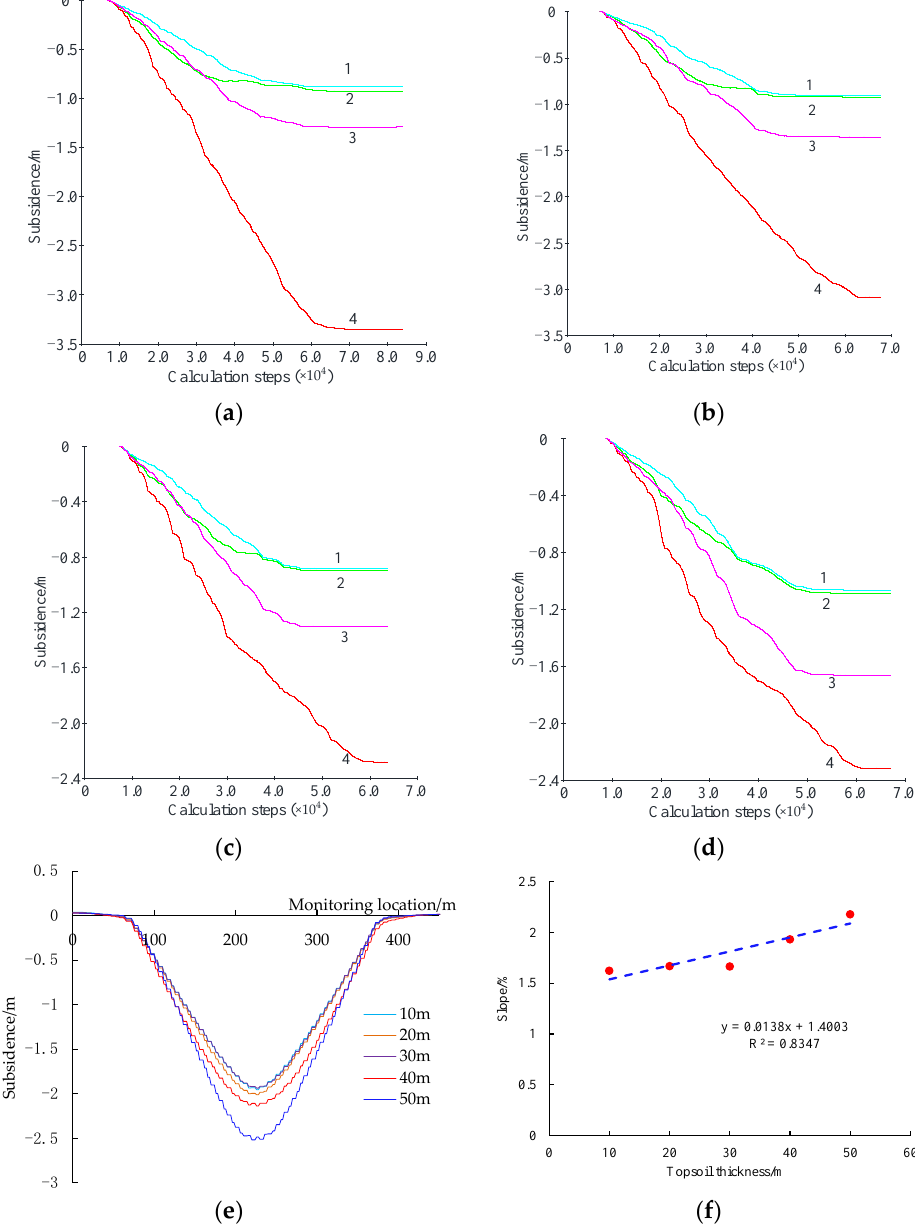
Figure 18. Strata movement and surface subsidence due to mining with different thickness of the topsoil (see Figure 14 for the line number). ( a ) 10 m; ( b ) 20 m; ( c ) 30 m; ( d ) 50 m; ( e ) surface subsidence; ( f ) slope.